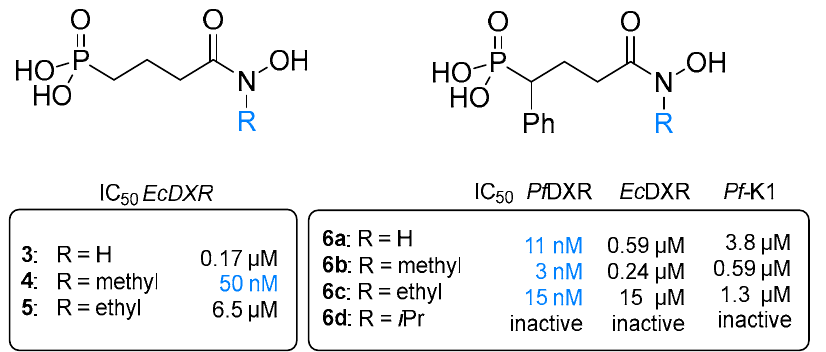
Figure 9. Structures, antibacterial, and antiplasmodial activities of the reverse fosmidomycin analogs 3 – 6 .